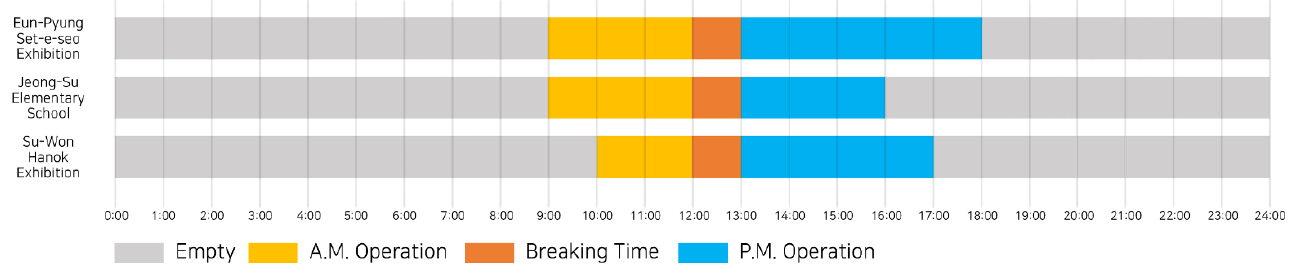
Figure 3. Operation schedules of selected target Hanoks.